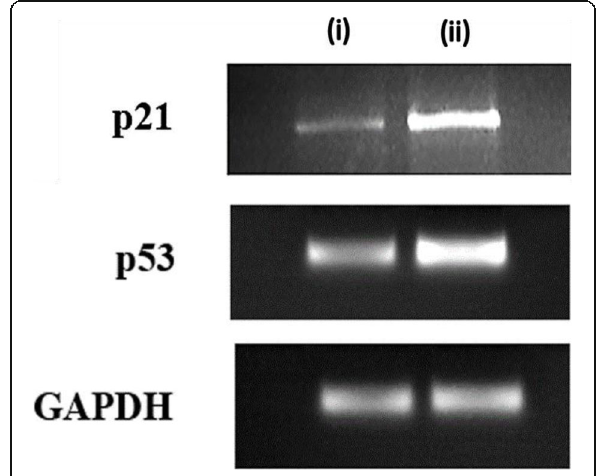
Fig. 5 Gene expression analysis of p21, p53, and GAPDH genes in (i) control cells and (ii) treated cells